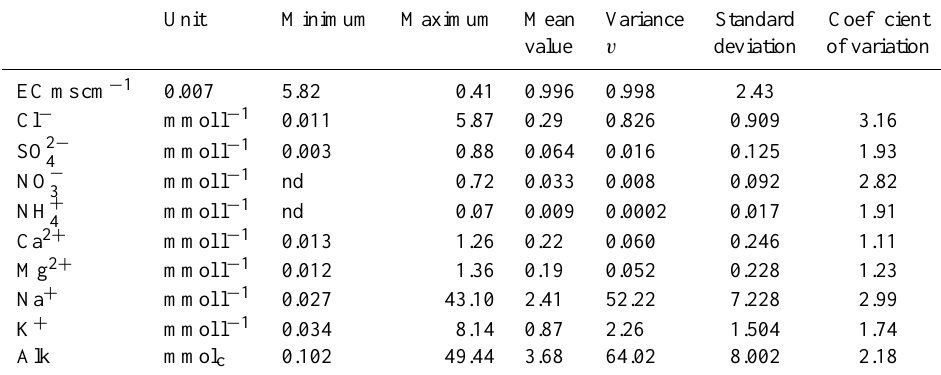
Table 5. Descriptive statistics of major elements in sampling NH (Nhecolˆandia).